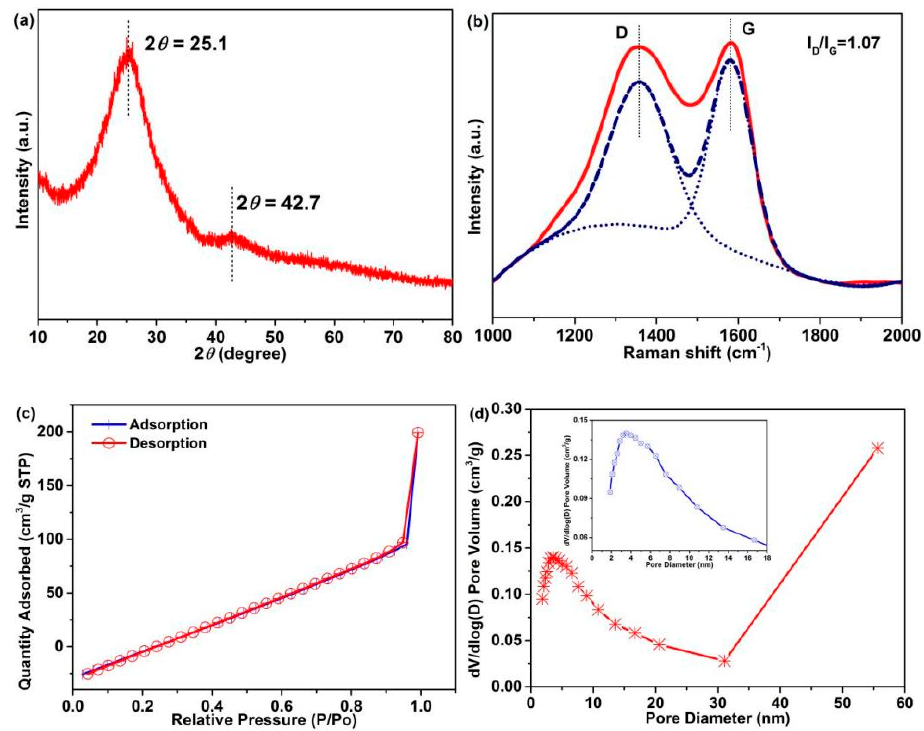
Figure 8. ( a ) XRD pattern, ( b ) Raman spectra, ( c ) nitrogen adsorption–desorption isotherm ( d ) and